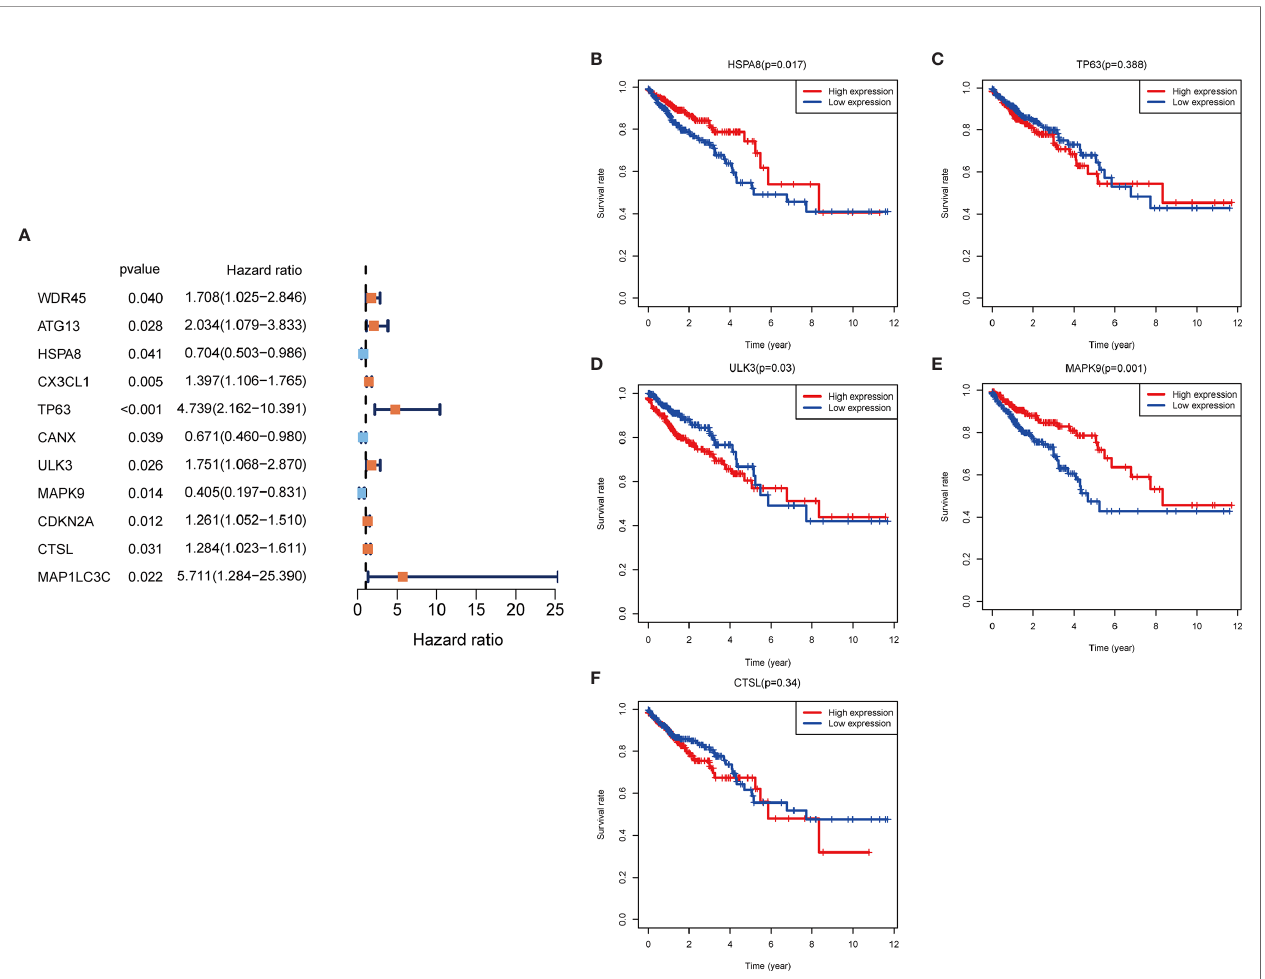
FIGURE 3 | Autophagy gene prognosis analysis. (A) Forest plot: Univariate COX regression analysis yielded prognosis-related genes, high risk genes: HR>1, low risk genes: HR<1. (B – F) Survival analysis of HSPA8, TP63, ULK3, MAPK9 and CTSL genes. The HSPA8 and MAPK9 high expression groups had better survival rates, while the other genes were not signi fi cantly different. HR, Hazard